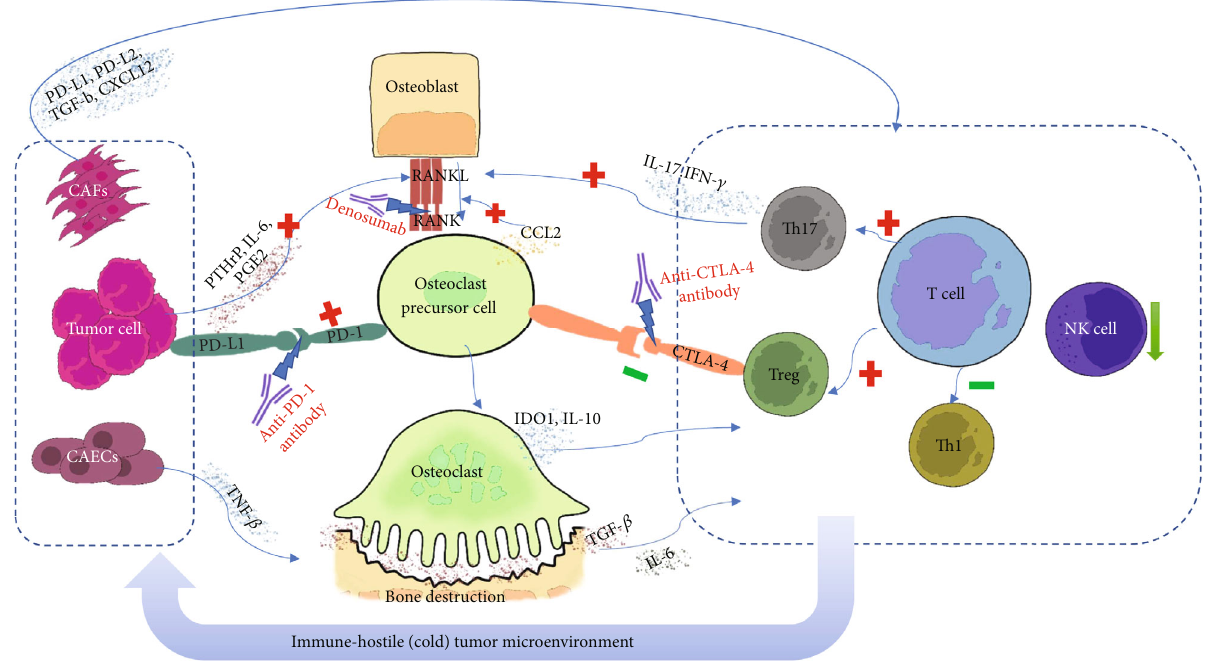
Figure 2: The interaction among the bone, immune system, and cancer cells. Tumor cells secrete PTHrP, PGE2, and other substances, which promote the transformation of osteoblasts into osteoclast precursors through the RANKL pathway and then di ff erentiate into osteoclasts, causing bone destruction. Tumors can induce the release of CCl2 from the osteoclast precursors through the PD-1 pathway, which again promotes the occurrence of RANKL-induced osteoclasts. Osteoclasts secrete IDO-1, IL-10, and other substances to induce immunosuppression. TGF- β released by the destruction of bone and IL-6 in the microenvironment also causes immunosuppression. T cells di ff erentiate into T 17 and Treg instead of T 1, forming an immune-hostile (cold) tumor microenvironment. T 17 secretes IL-17 h h h and IFN- γ to promote osteoclast di ff erentiation, while Treg cells rely on the CTLA-4 pathway to inhibit the transformation of osteoclast precursors to osteoclasts. PTHrP: parathyroid hormone-related peptide; PGE2: prostaglandin E2; CCI2: chemokine (C-C motif) ligand 2; IDO-1: indoleamine 2,3-dioxygenase 1; IL: interleukin; TGF- β : transforming growth factor- β ; IFN- γ : interferon- γ